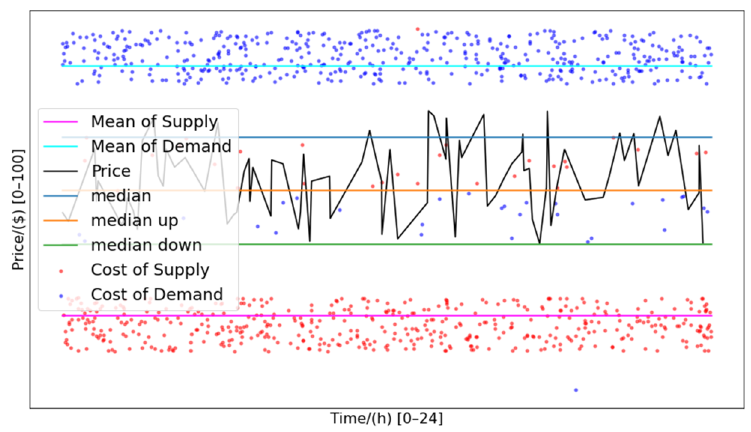
Figure 7. Price ranges.